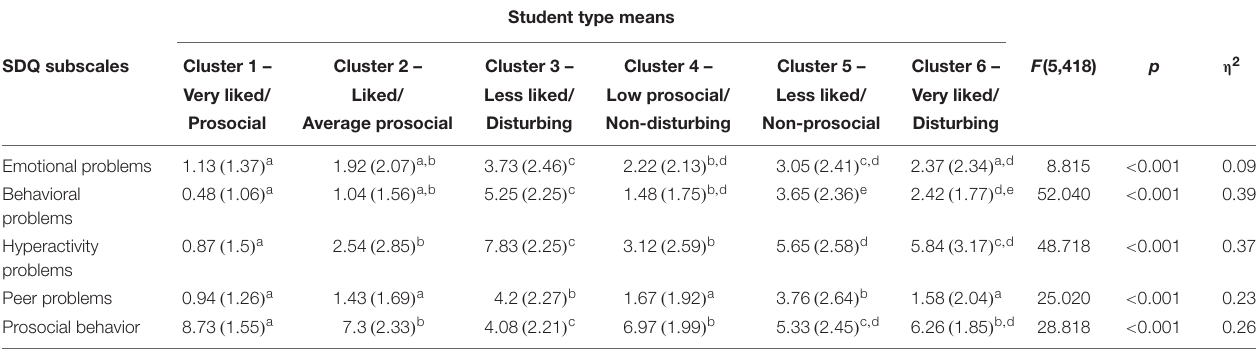
TABLE 4 | Effects of typology on SDQ subscales: Descriptive statistics, univariate ANOVA tests, pairwise comparisons and partial eta